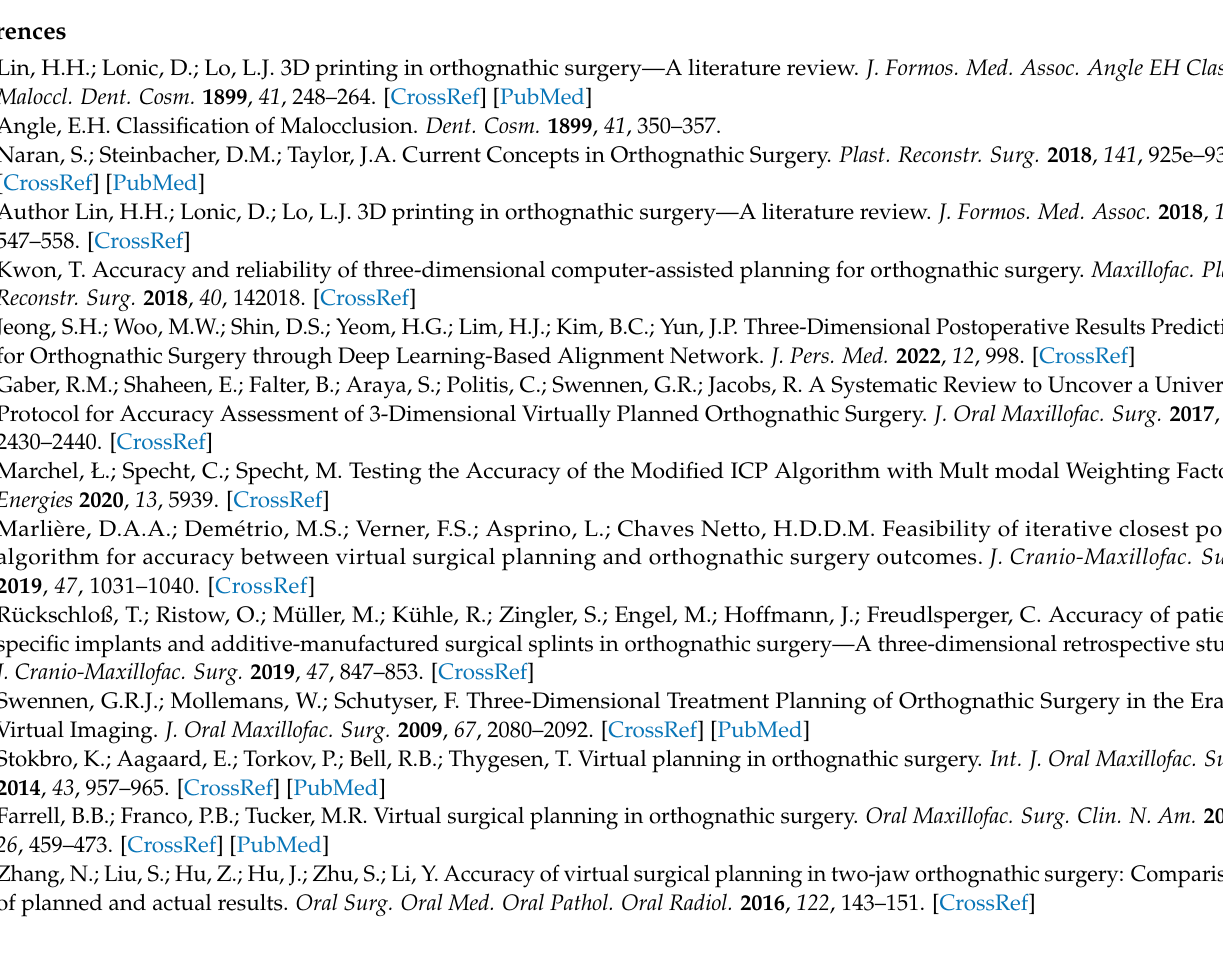
the study; Table S2: Summary of the 3D comparison (RMSE) in the three groups